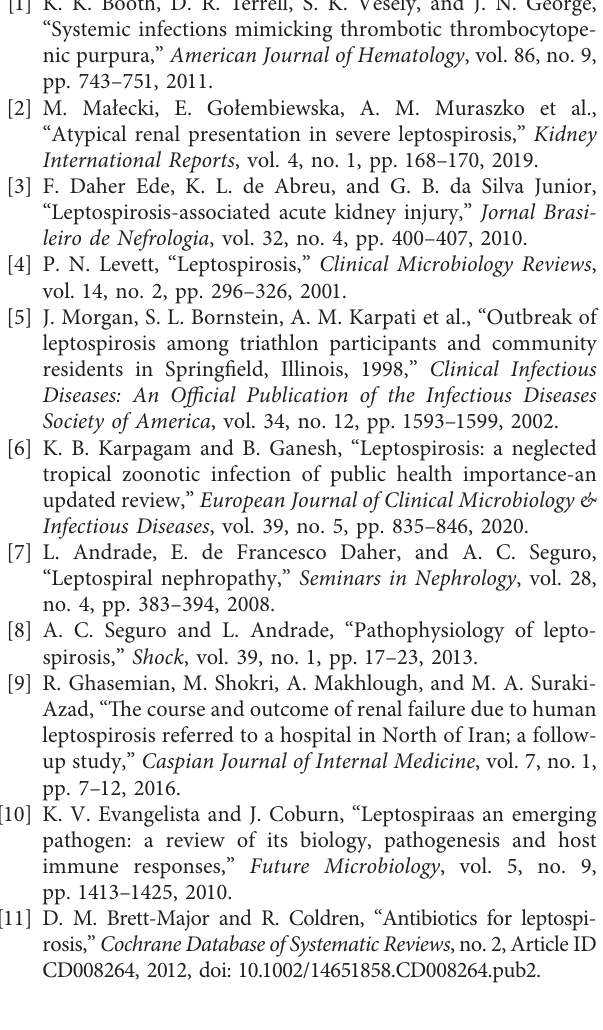
Table 3: Differential diagnosis of acute kidney injury with jaundice. Acute thrombotic microangiopathy (TMA) includes TTP and HUS Thrombotic thrombocytopenic purpura (TTP) Haemolytic uremic syndrome (HUS) Atypical haemolytic uremic syndrome (aHUS) Hepatorenal syndrome Rhabdomyolysis Leptospirosis/Weil’s disease